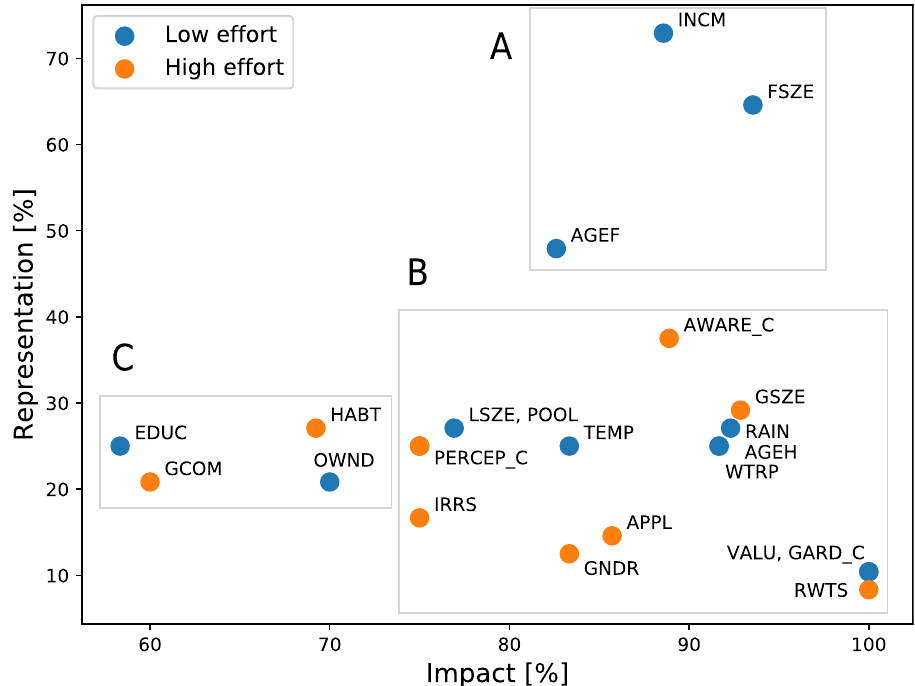
Fig. 7 Trade-off analysis of determinant representation, impact, and effort. Impact (x-axis) vs Representation (y-axis) vs Effort (color) of each determinant. Each point refers to a speci fi c determinant. See Tables 1 – 3 for determinant acronyms de fi nition. The determinants classi fi ed as “ High effort" are those with an effort value larger than 8.0, vice-versa for the “ Low effort" determinants. Determinants are organized in three groups: Group A - high impact, high representation, and low effort; Group B - medium-to-high impact, low representation, and mixed low and high effort; Group C - low representation, low impact, mixed